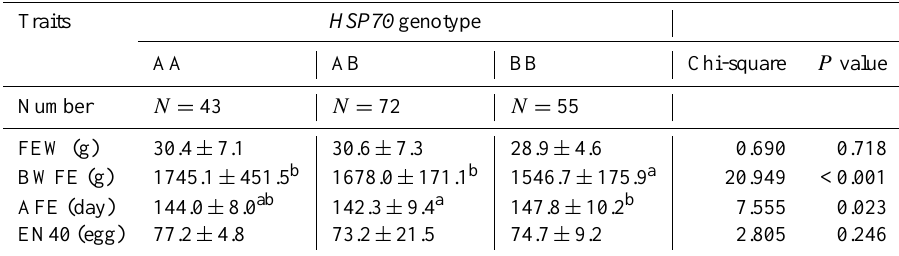
Table 4. The effect of HSP70 genotypes on egg production traits in the LRI native chickens. Traits HSP70 genotype AA AB BB Chi-square P value Number N = 43 N =